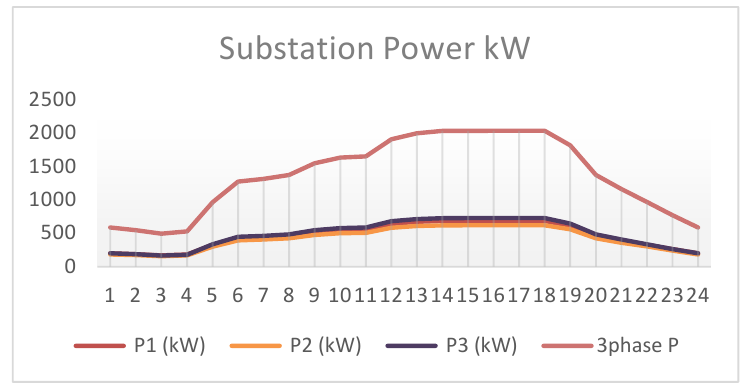
Figure 3 . Substation Daily Power Demand.